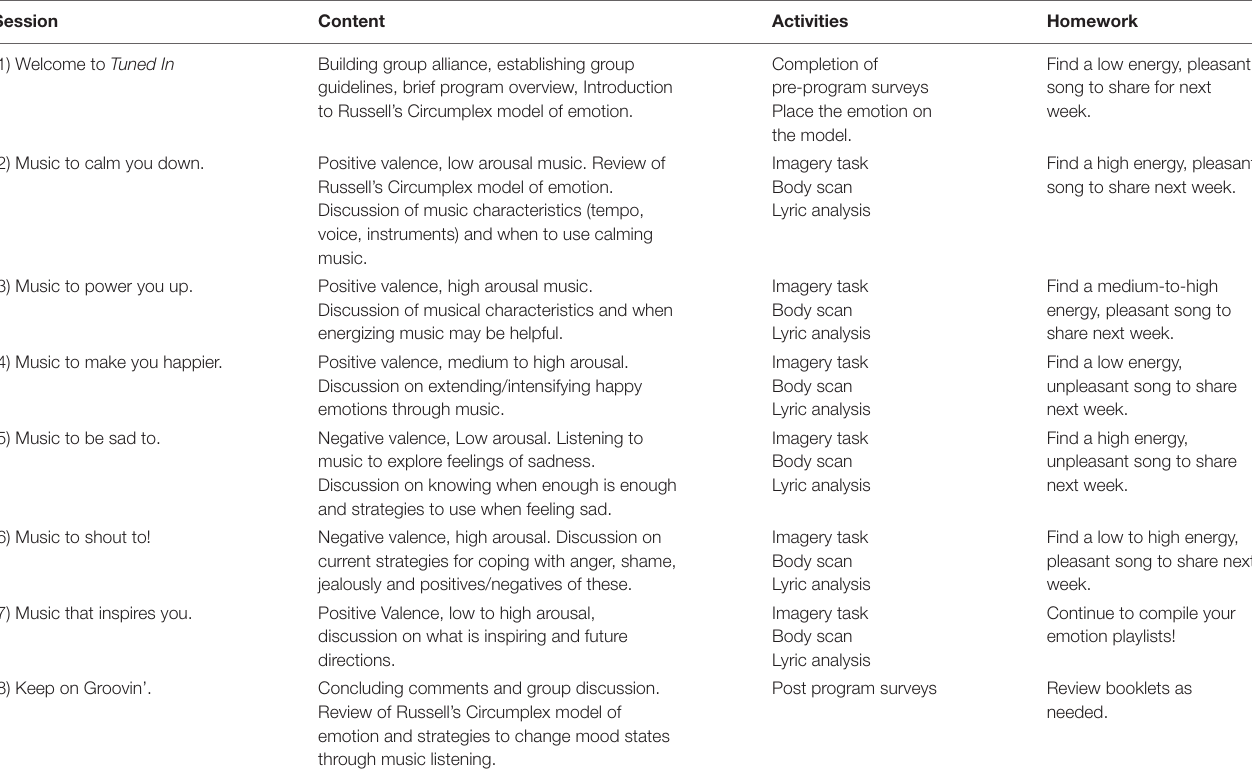
TABLE 1 | The Eight Session Version of Tuned In Used with the At-Risk Adolescent